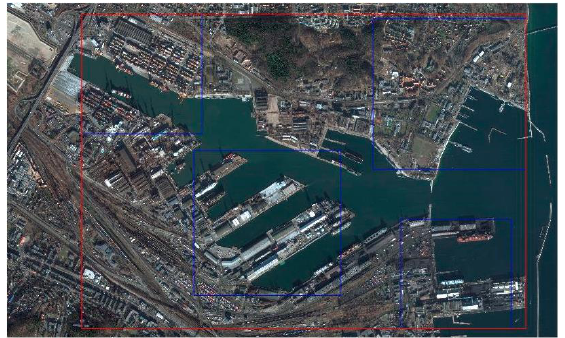
Figure 8. Detection on Gdynia Port in Poland